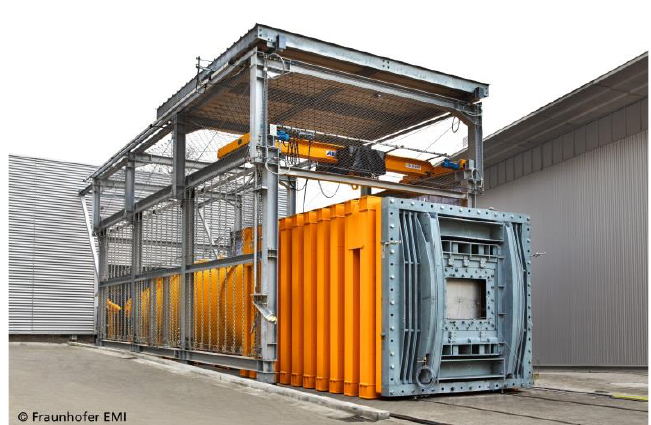
Fig. 1 Blast-star shock tube at the Fraunhofer EMI site in Efringen-Kirchen.